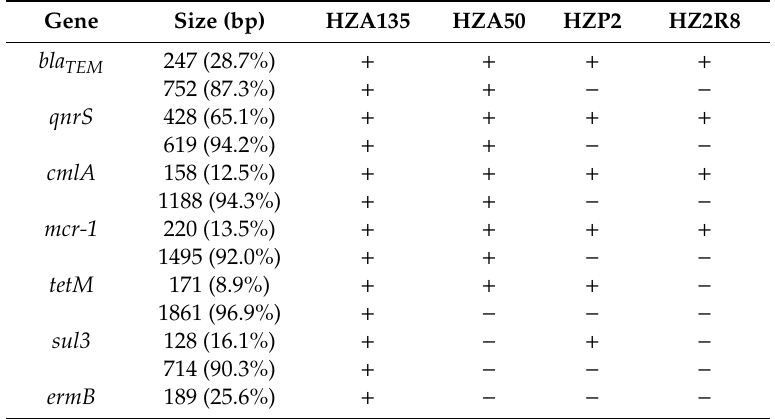
Figure 6. The potential packaging of antibiotic resistance genes (ARGs) in phage HZP2 ( A ) and HZ2R8 ( B ). Data are from three independent cultures, and one standard deviation is shown. Significant changes were marked with two asterisks for p < 0.05, otherwise marked with one asterisk. Table 1. Target ARG results of hosts and phage.